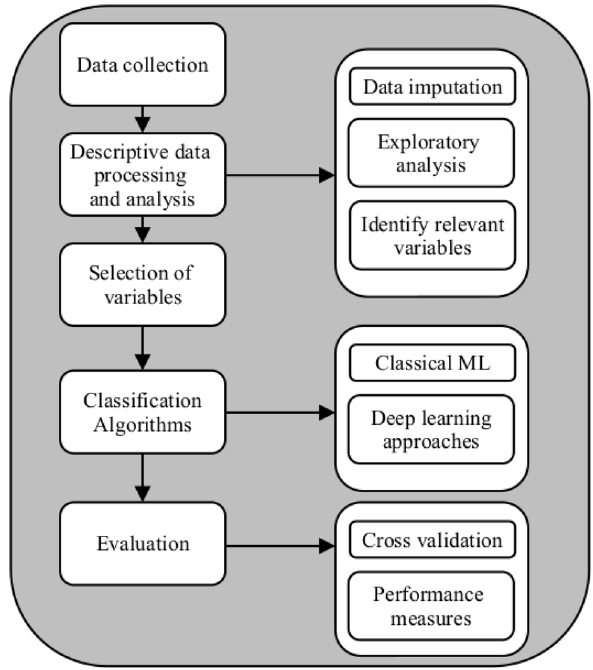
Figure 2. Information processing flowchart to find out the